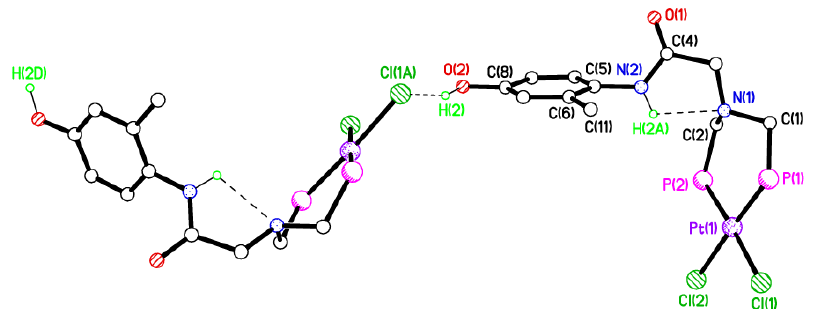
Figure 14. Packing plot in the crystal structure of 5b . Phenyl groups and hydrogen atoms not involved in hydrogen bonding have been omitted for clarity.